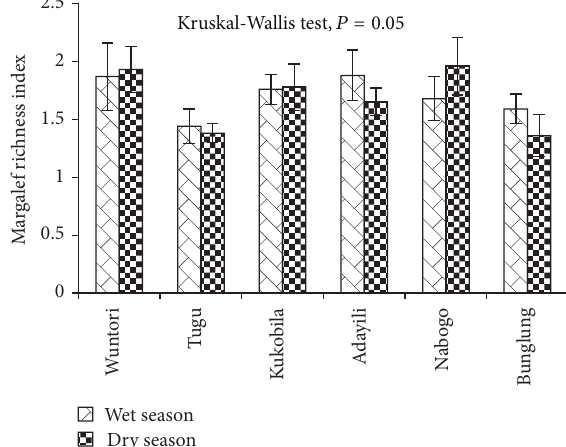
Figure 5: Comparison of bird richness in the six wetlands in wet and dry